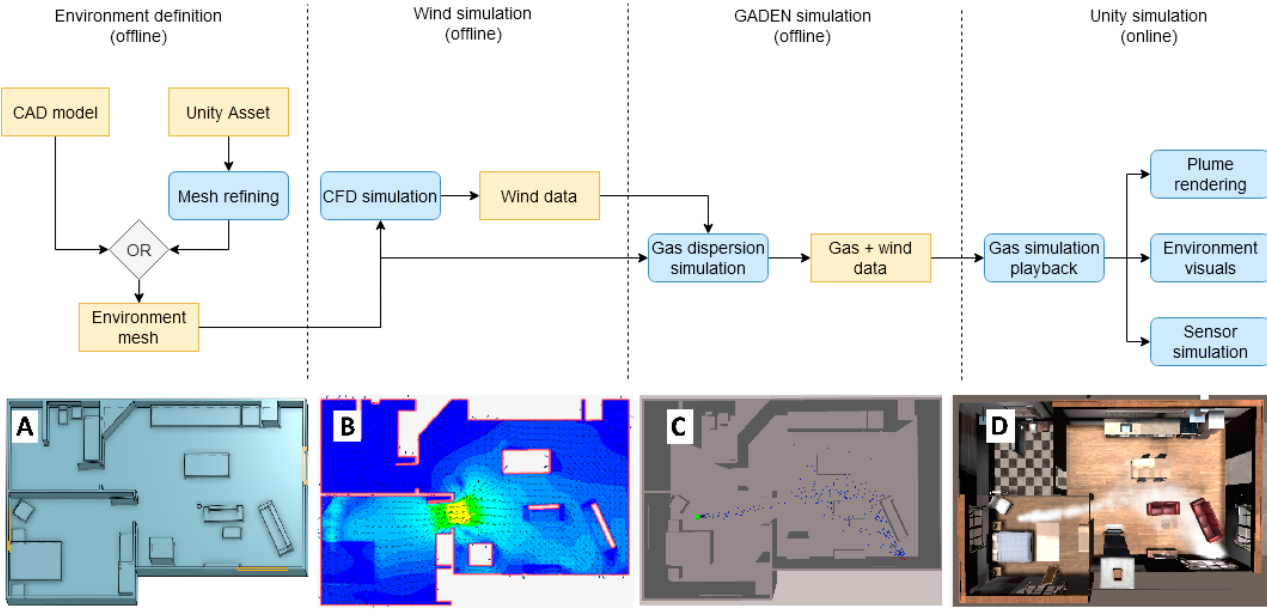
Figure 3. Flow diagram that shows the different steps of the simulation. Most of the work is conducted offline to keep the computational load of the online phase low. ( A ) shows the mesh model that defines the environment, ( B ) shows the airflow vector field computed by CFD , ( C ) shows the filament dispersion simulation in GADEN, and ( D ) shows the integration and visualization of the result in